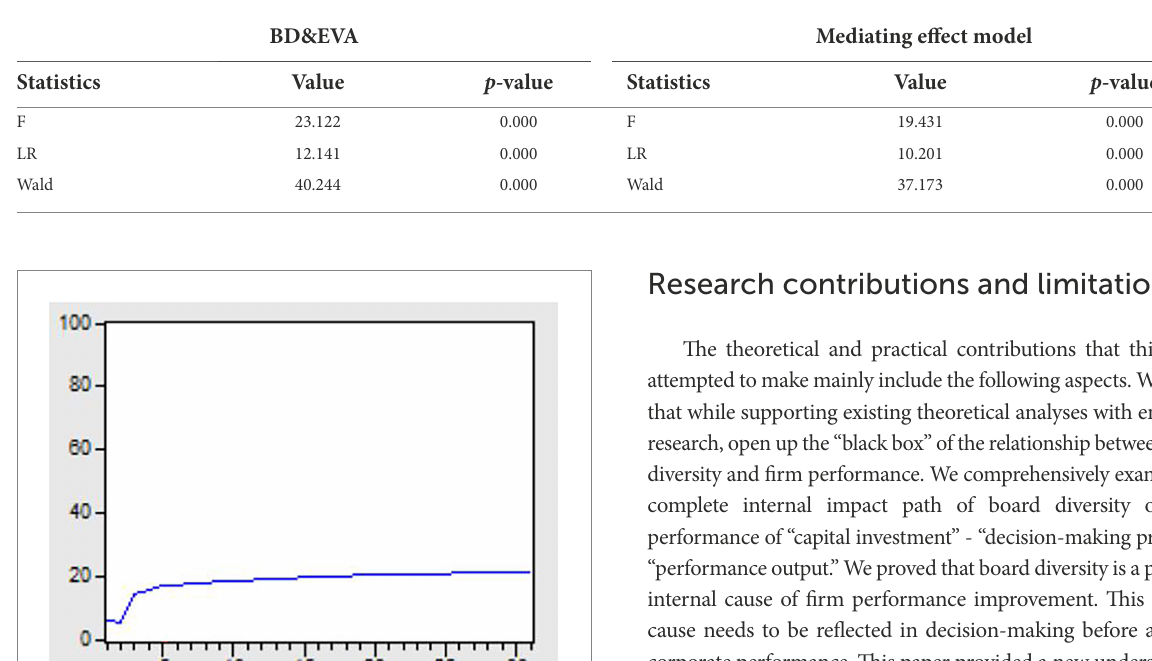
TABLE 9 Robustness test for BD & EVA, and mediating effect model.